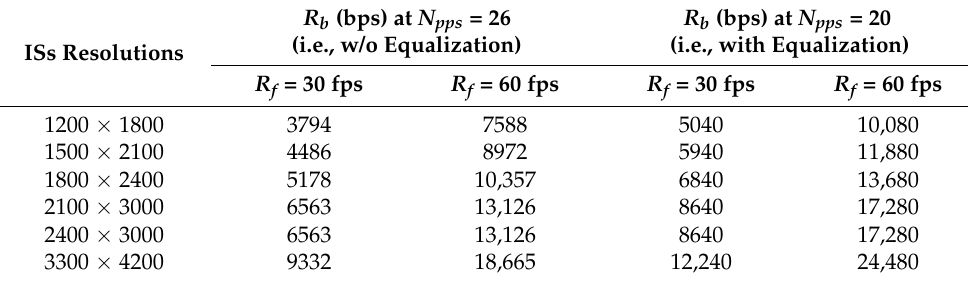
Table 4. Effective R b at different ISs resolutions at the FEC